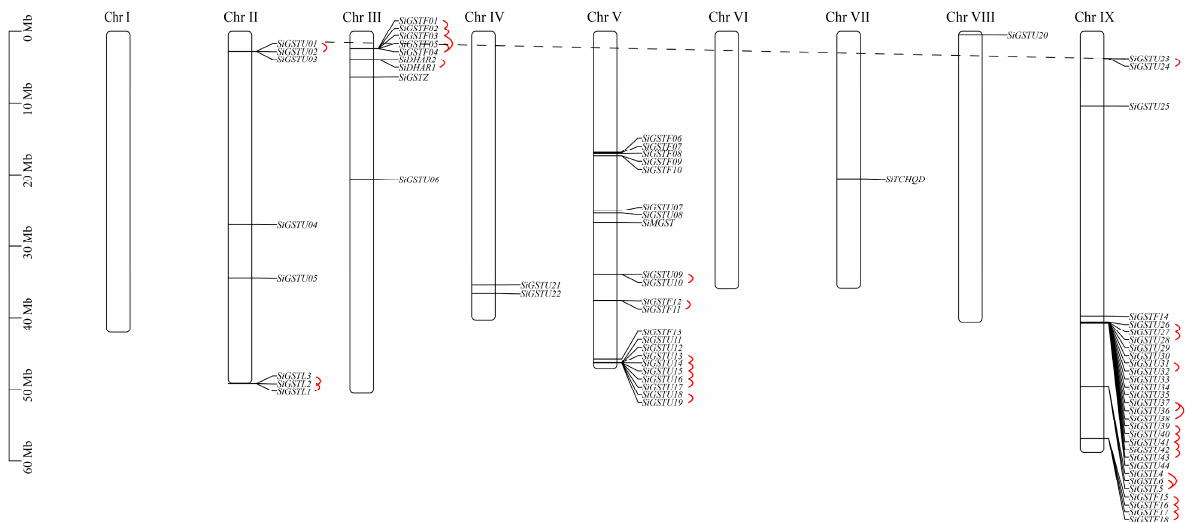
Figure 2. Chromosome mapping of GST genes in foxtail millet. A total of 30 tandem duplication gene pairs belonging to 11 clusters were present (highlighted by full red lines). Only one pair of gene segmental duplication event was found (highlighted by dashed black line).